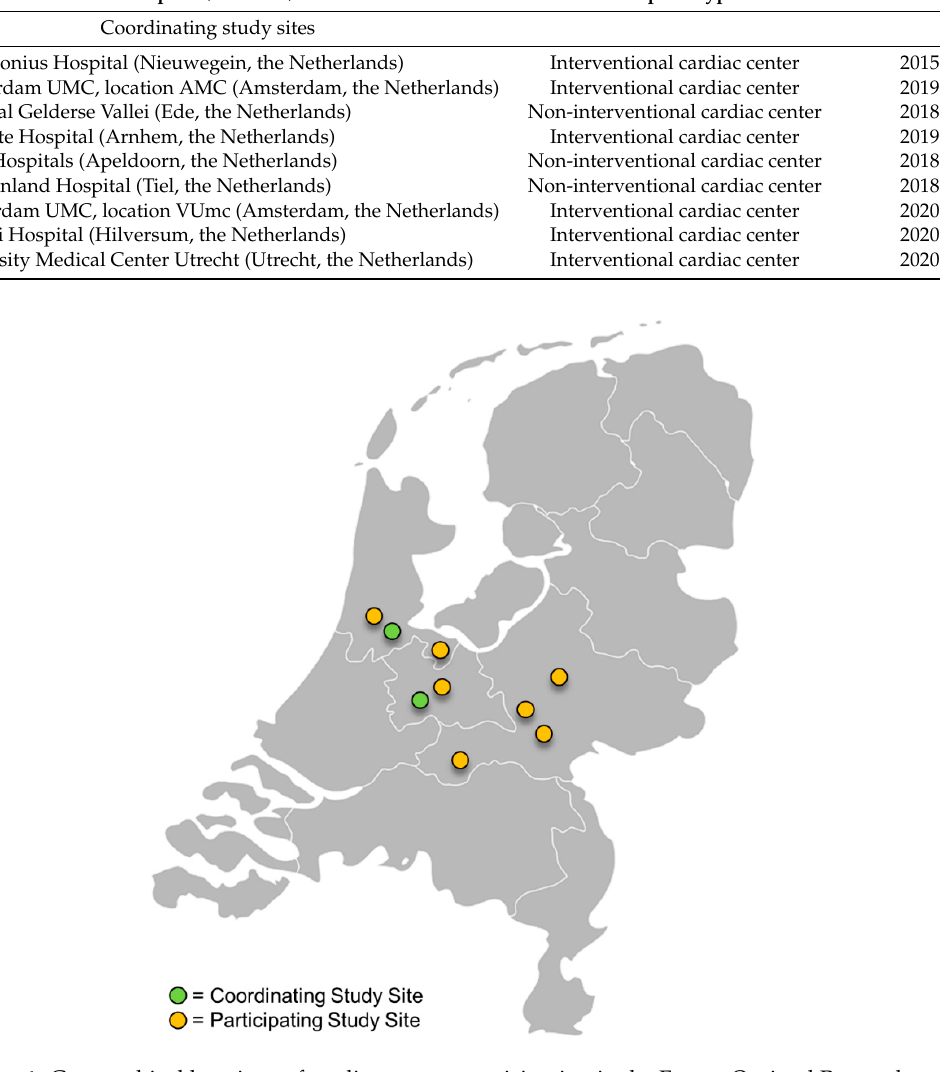
Figure 1. Geographical locations of cardiac centers participating in the Future Optimal Research and Care Evaluation in patients with Acute Coronary Syndrome (FORCE-ACS) registry.